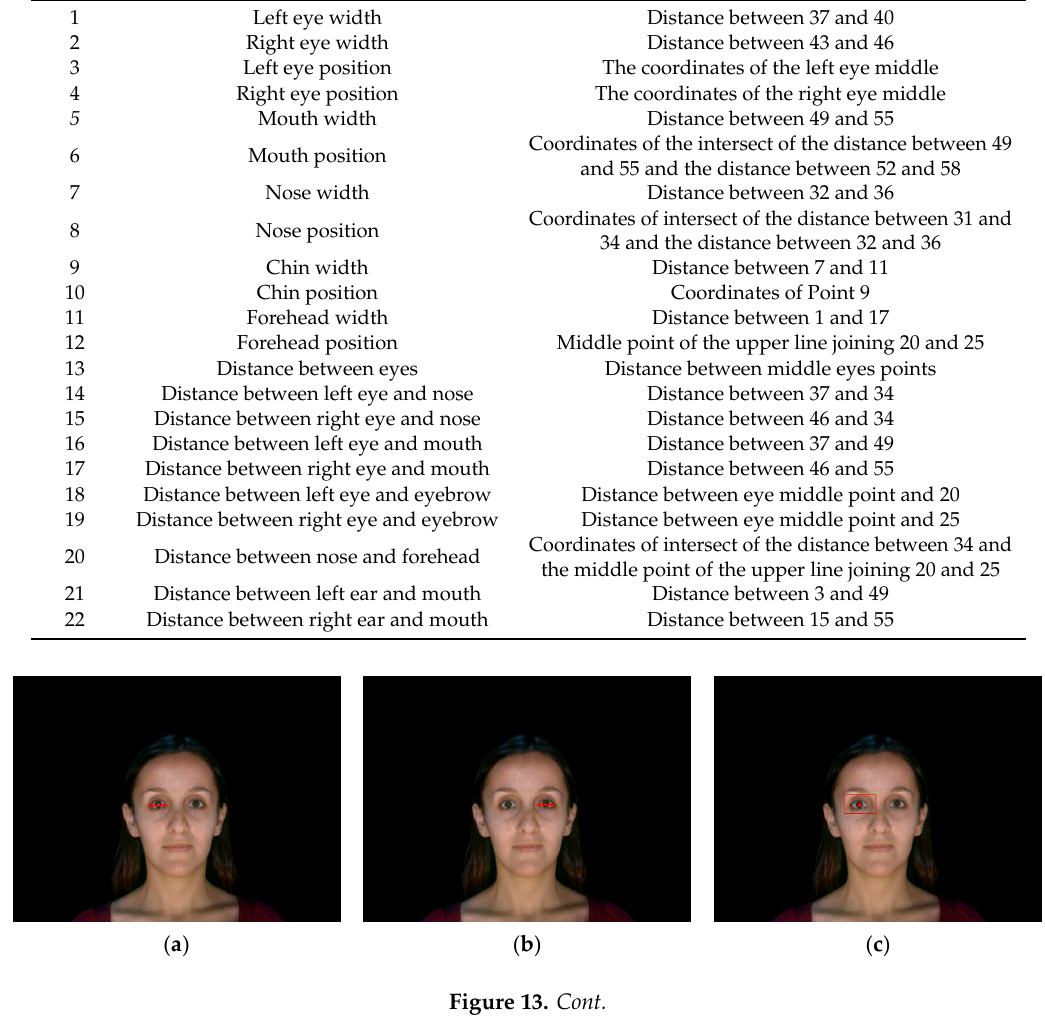
Table 2. Facial features and the corresponding points in 68 landmarks